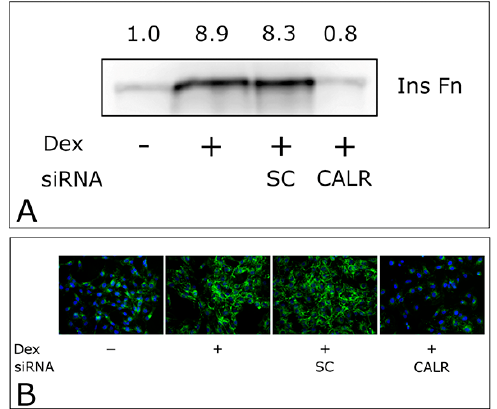
Figure 4. CALR siRNA blocks FNMA in dexamethasone treated GBM cells. Immunoblot ( A ) and immunofluorescence ( B ) assays demonstrating the effects of CALR siRNA on FNMA in GBM cells. Note the significant reduction in the production of an insoluble fibronectin matrix (InsFn) in the presence of the CALR siRNA relative to a scrambled control (SC). Green signal (assembled fibronectin matrix), blue signal (DAPI counterstain).